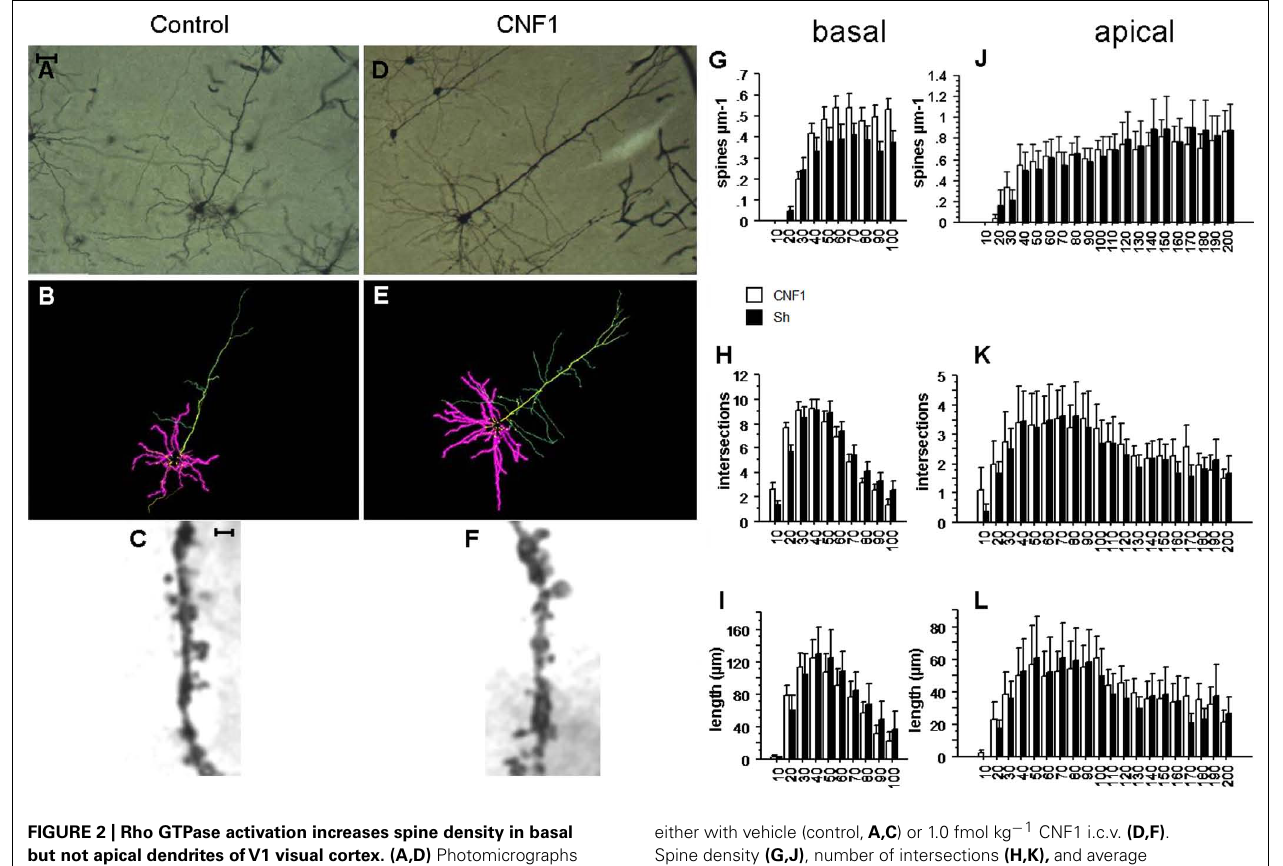
FIGURE 2 | Rho GTPase activation increases spine density in basal but not apical dendrites ofV1 visual cortex. (A,D) Photomicrographs (scale bar 100 μ m); (B,E) Neurolucida tracings; (C,F) detail of apical dendrite (scale bar 2 μ m) of representative Golgi stained neurons in V1 visual cortex of C57BL/6J mice treated 10 days before